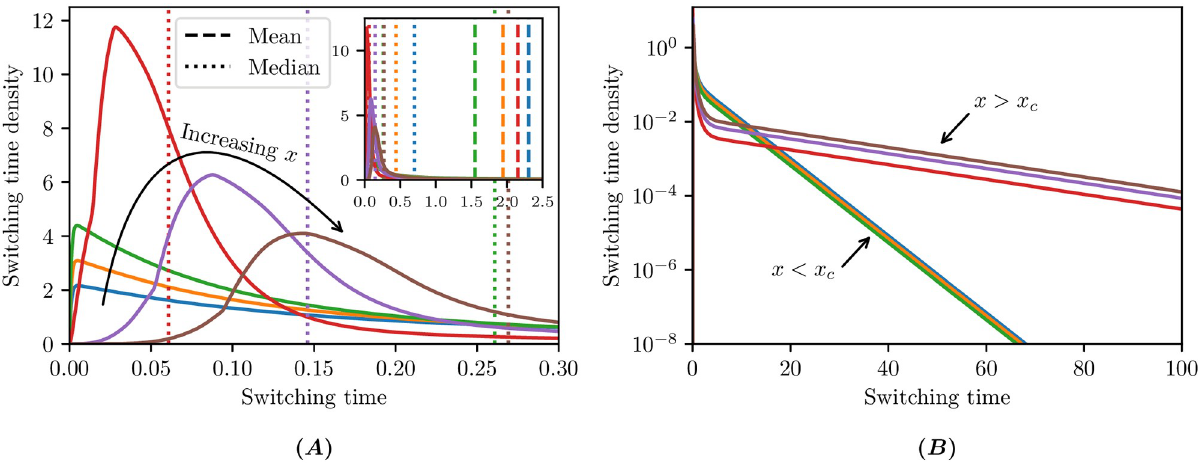
Fig 5. Extended switching time distributions. From the same data used to produce Fig 4 with the initial conditions x 2 {0.7, 0.75, 0.8, 0.85, 0.9, 0.95}. (A) Zooming in to a small time interval resolves the modes, while (A inset) zooming out far enough to see the mean switching times shows the distribution skew. (B) The heavy tails are shown on a logarithmic scale for large times.